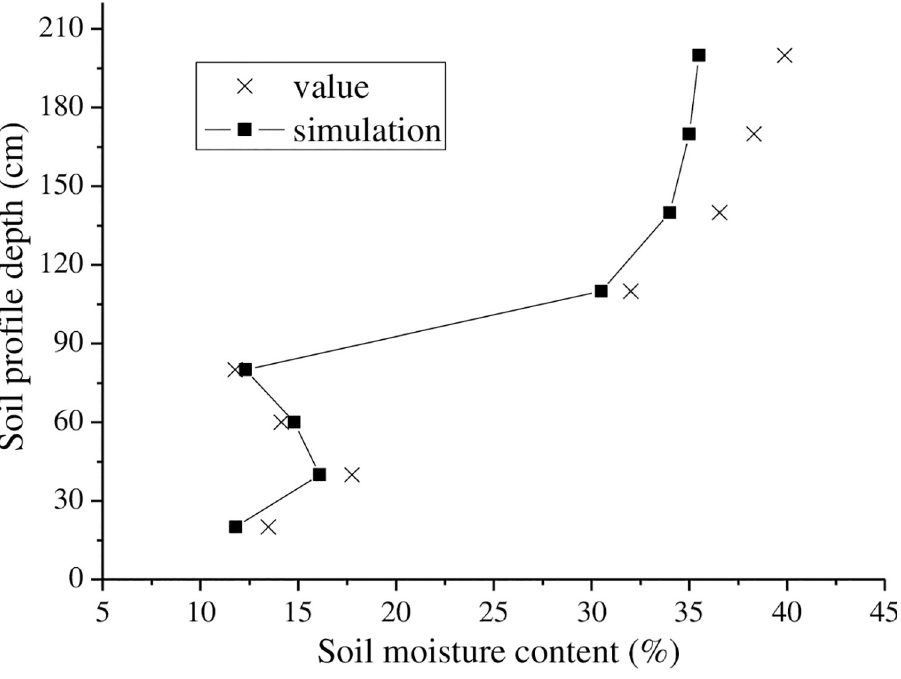
Fig 13. Measured value compared with simulated value of soil moisture content (2018-01-20).